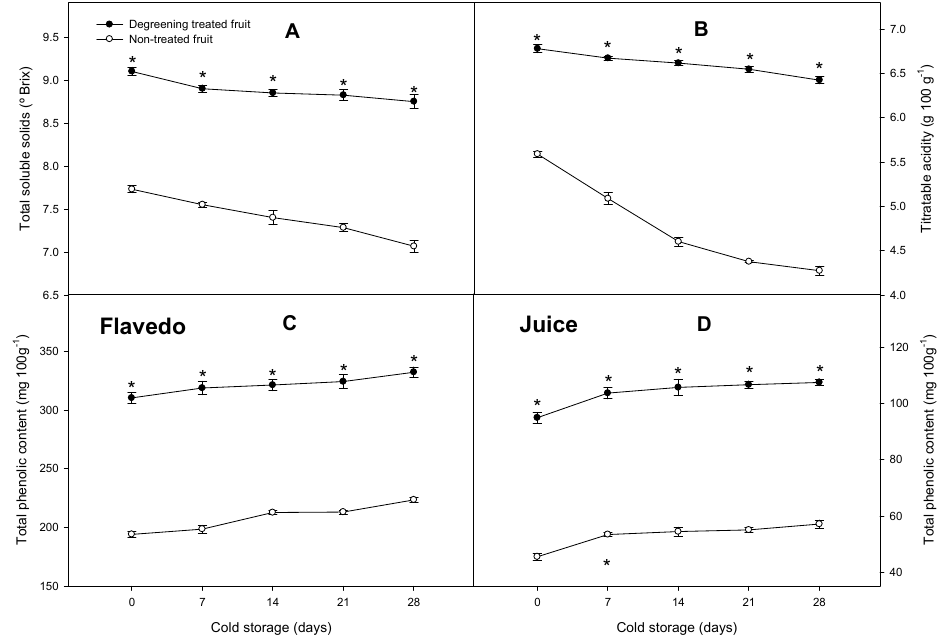
Figure 5. Effect of degreening treatment on total soluble solids ( A ), titratable acidity ( B ), and total phenolic content in flavedo ( C ) and juice (D ) in lemon fruits stored for 28 days at 10 °C. Asterisks (*) show significant differences between treated and non-treated fruits at p < 0.05.